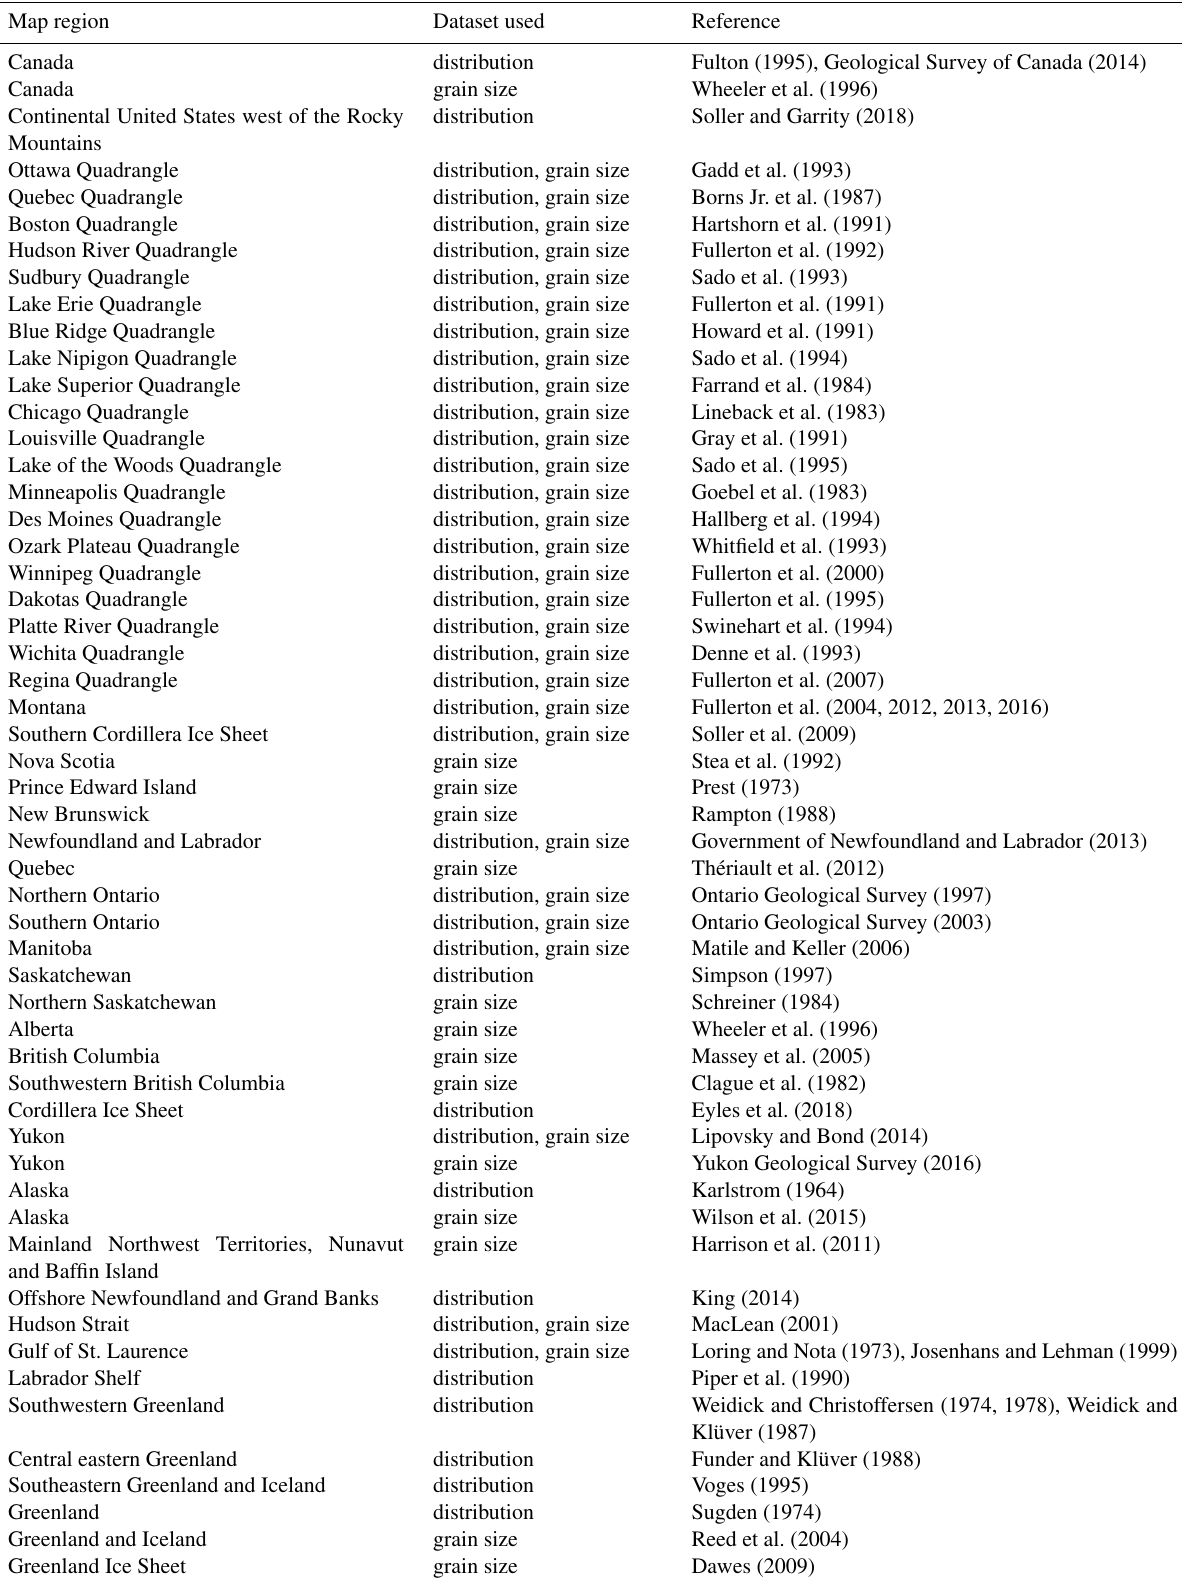
Table 1. Maps used for the creation of the distribution and grain size dataset. Map